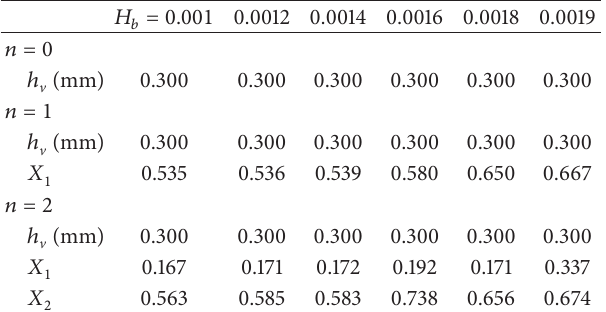
Table 5: Final values of design variables ( 𝐻 𝑏 + 𝐻 𝑐 = 0.002 ).